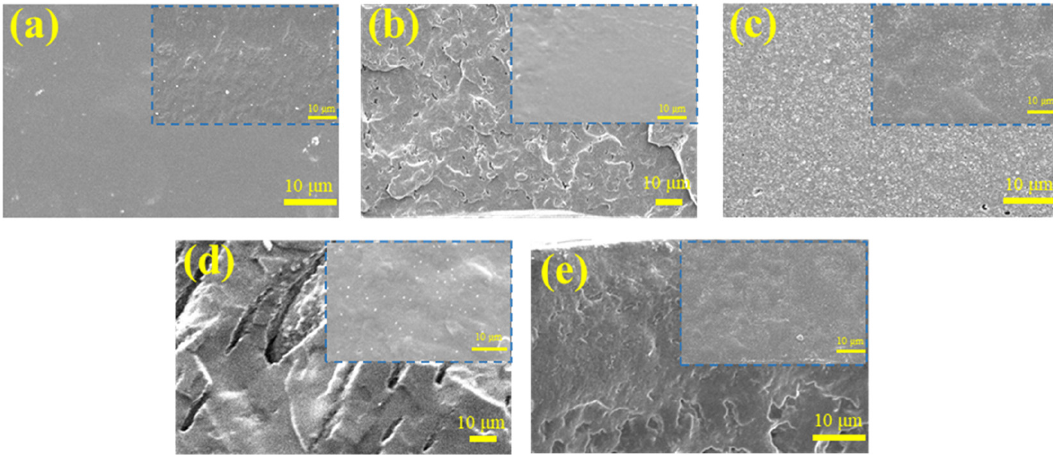
Figure 5. The SEM images of the cross-section of latex film with PVP before (inset images) and after washing: ( a ) using 0% of PVP; ( b ) using 10% of PVPK30; ( c ) using 15% of PVPK30; ( d ) using 15% of PVPK15; and ( e ) using 30% of PVPK15.